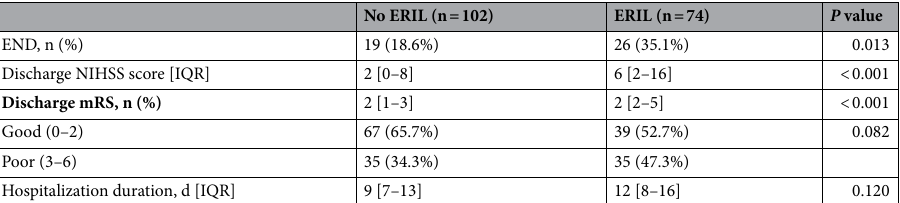
Table 4. Differences in subsequent prognosis between patients with and without early recurrent ischemic lesions. ERIL early recurrent ischemic lesion, END early neurological deterioration, NIHSS National Institutes of Health Stroke Scale, mRS modified Rankin